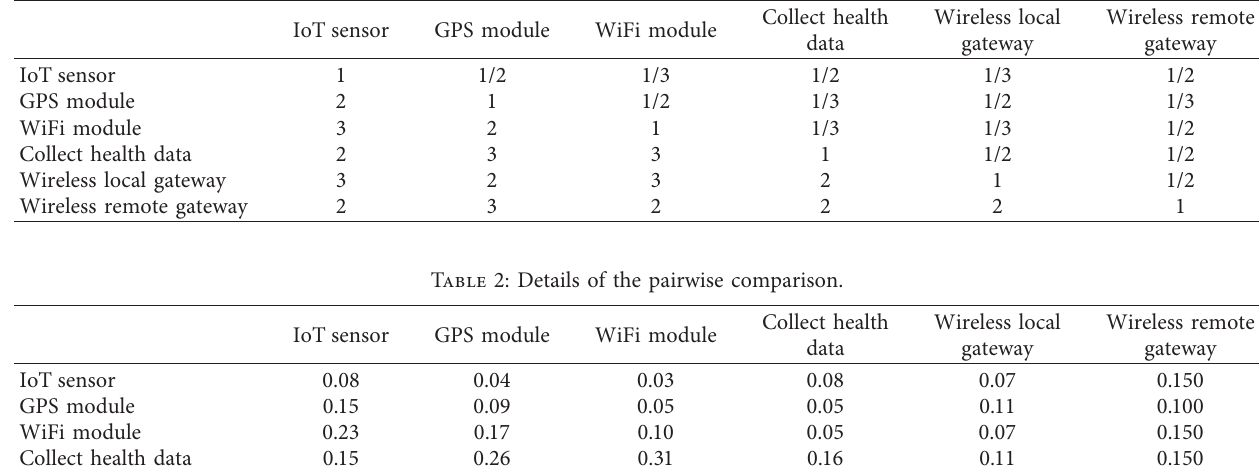
Table 1: Details of the components involved.